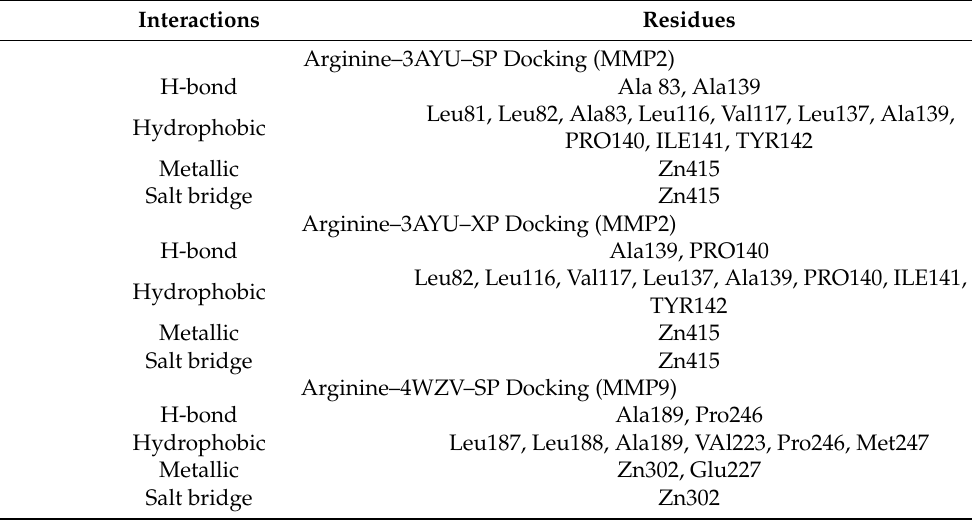
Figure 3. Binding of L-arg on the active site of MMPs protein as assessed by molecular docking. ( A ) Arginine–3AYU–SP docking-2D interaction diagram. The 2D surface view of docking of arg (blue) in the ( B ) catalytic cavity of MMP-9; it interacts with Zn as arg 149, forming hydrogen bonds extending in the S1 (cid:48) pocket. ( C ) The docking of arginine in the MMP-2 protein shown in 3D form with the secondary structure of protein visible. ( D ) The surface view of docking of arg in the catalytic cavity of MMP-2 and the interaction of arg. Table 3. Detailed observations of docking poses of arg and its interactions with key residues of binding site in all the three docking protocols (SP, XP and Induced-Fit) with MMP-2 and MMP-9 and IFD docking